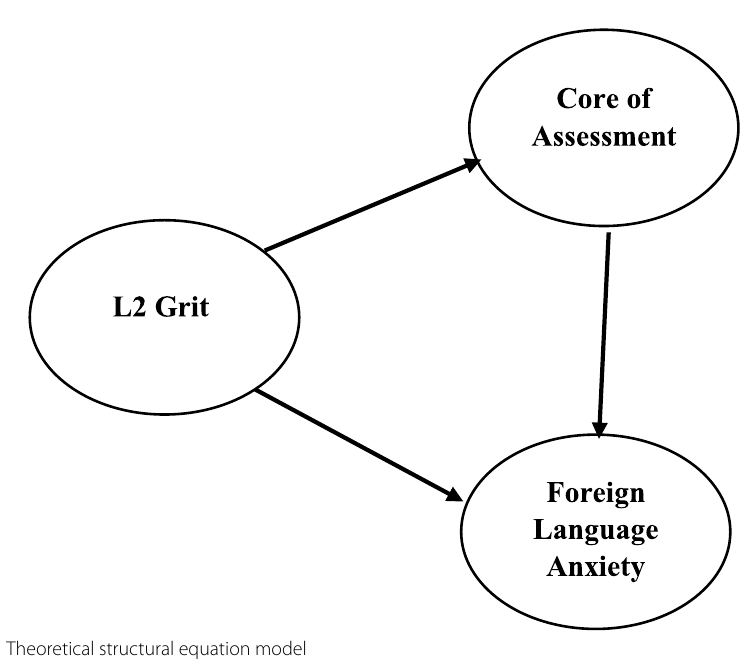
Fig. 1 Theoretical structural equation